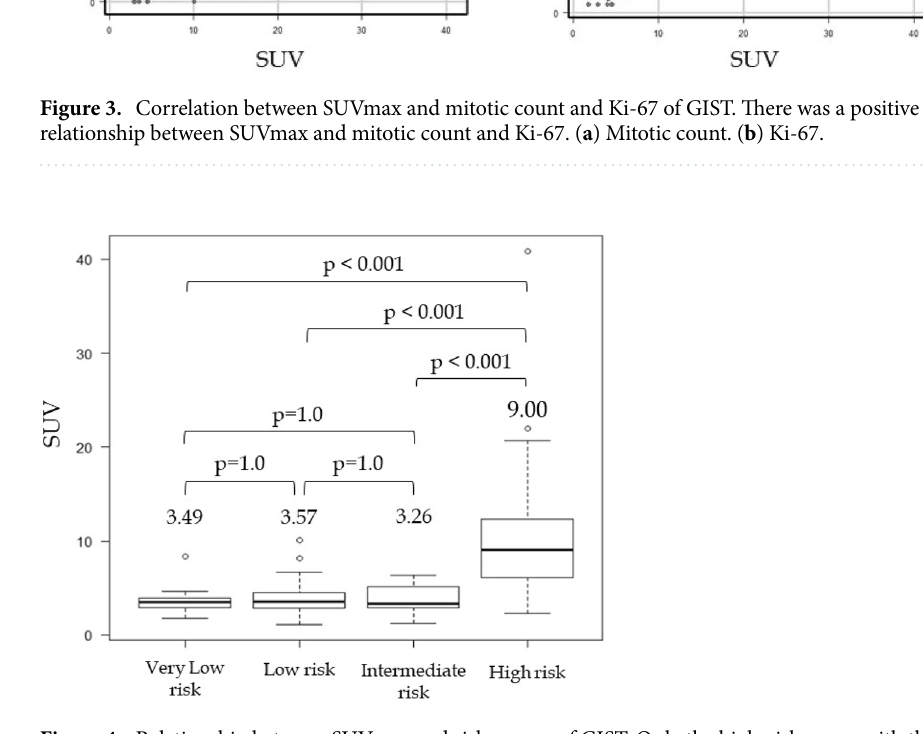
Figure 4. Relationship between SUVmax and risk groups of GIST. Only the high-risk group with the highest malignancy of GIST had a significantly higher SUVmax. SUVmax showed no statistically significant difference between the other risk groups or the very low-, low-, and intermediate-risk